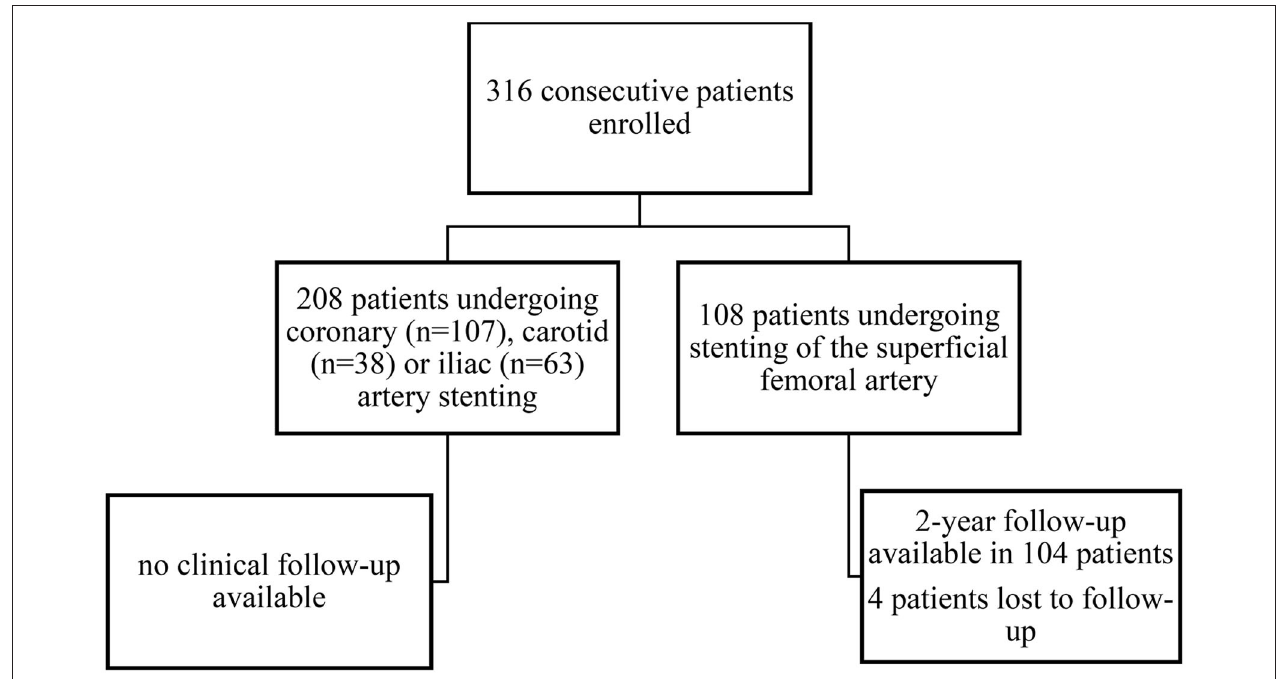
FIGURE 1 | Study design and procedural flow